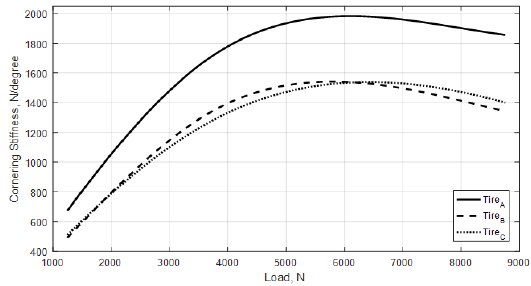
Figure 9. Tires’ cornering stiffness test results.